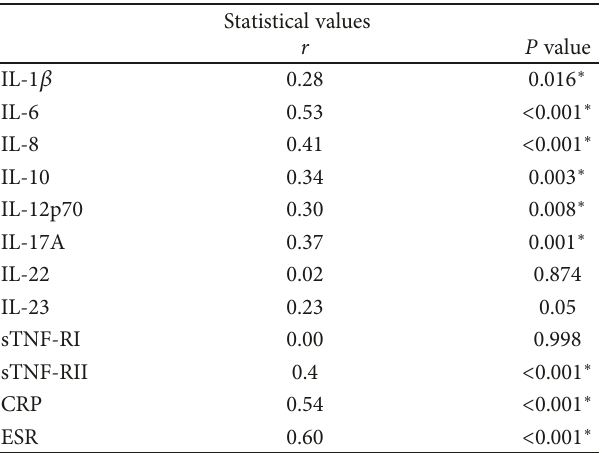
Table 5: Correlation among clinical in fl ammatory activity and in fl ammatory serum marker levels in patients with hidradenitis suppurativa based on their HS-PGA